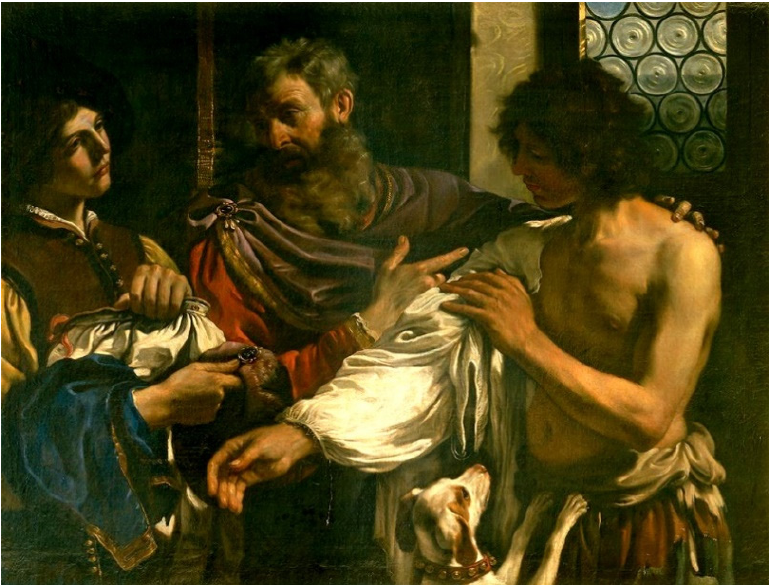
Figure 7. Guercino, Return of the Prodigal Son , 1627/8, Borghese Gallery, Rome. Photo: Wikimedia Commons, Public Domain.